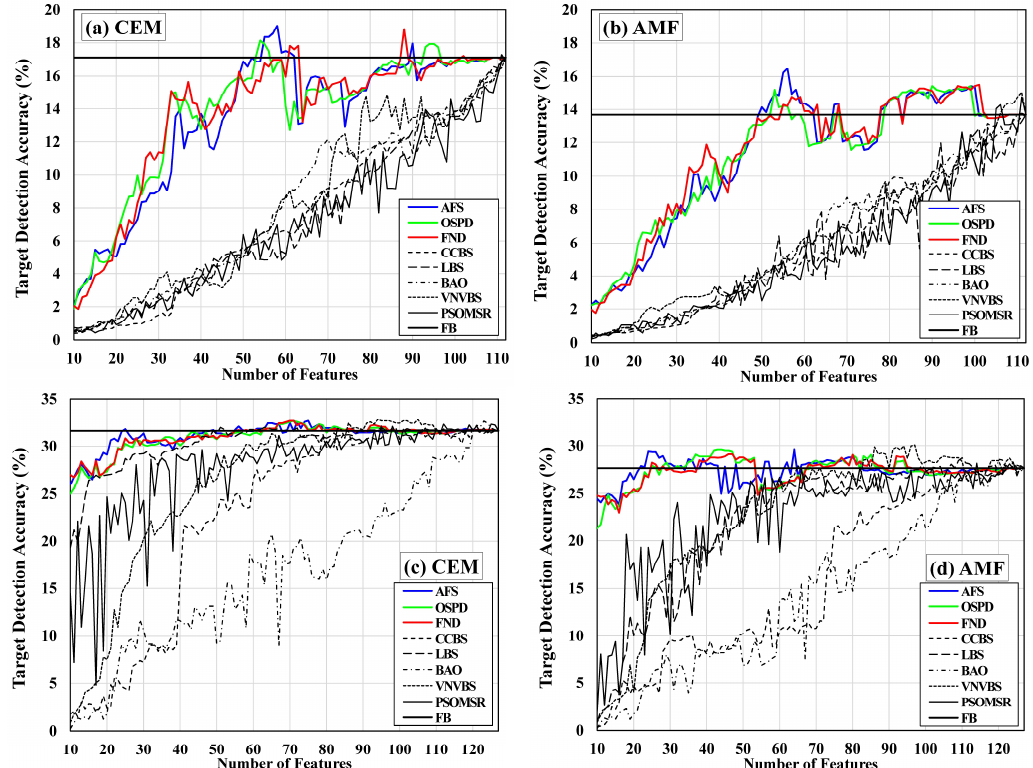
Figure 11. The best target detection accuracy (TDA) obtained by the CEM and AMF detectors using different feature selection (FS) methods. Figure ( a , b ) show the results for the HyMap dataset. The results of the SIM.GA dataset are displayed in figure ( c , d ). The curves in solid color lines are generated by the proposed FS methods. The black horizontal line in each figure indicates the full-band (FB) result for comparison with FS-based results.